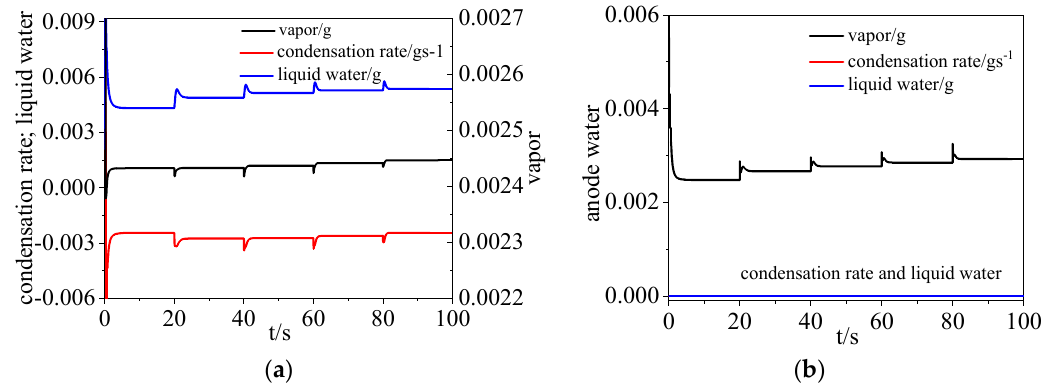
Figure 6. Calculated values for the water dynamics in the channel: ( a ) cathode channel water, ( b ) anode channel water.